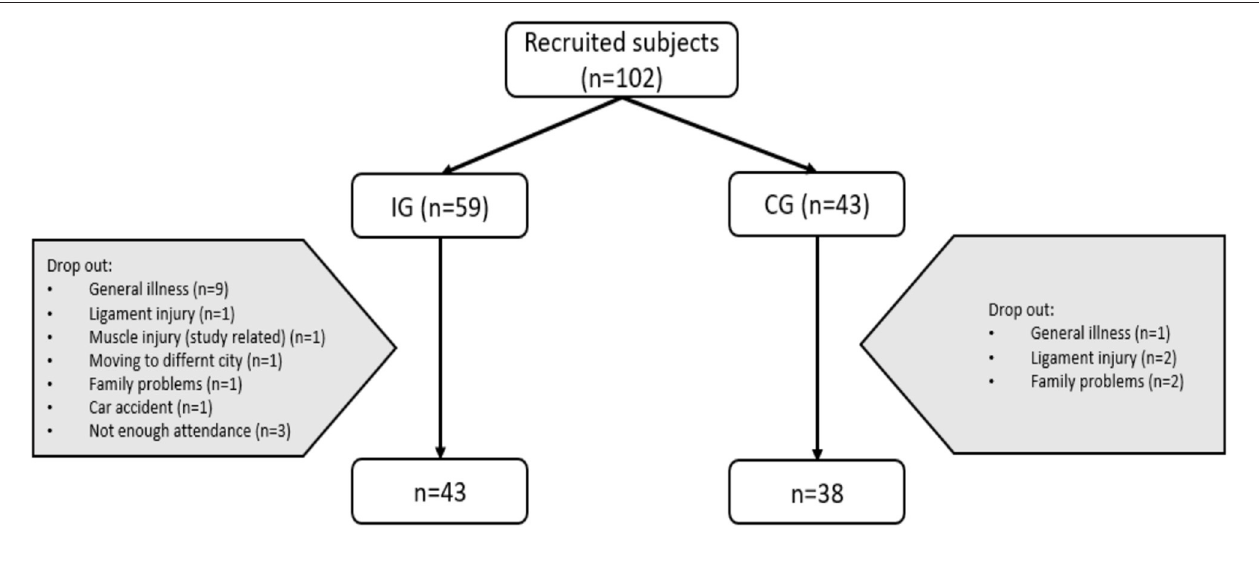
FIGURE 1 | Flowchart of participant recruitment and reasons for drop-out.